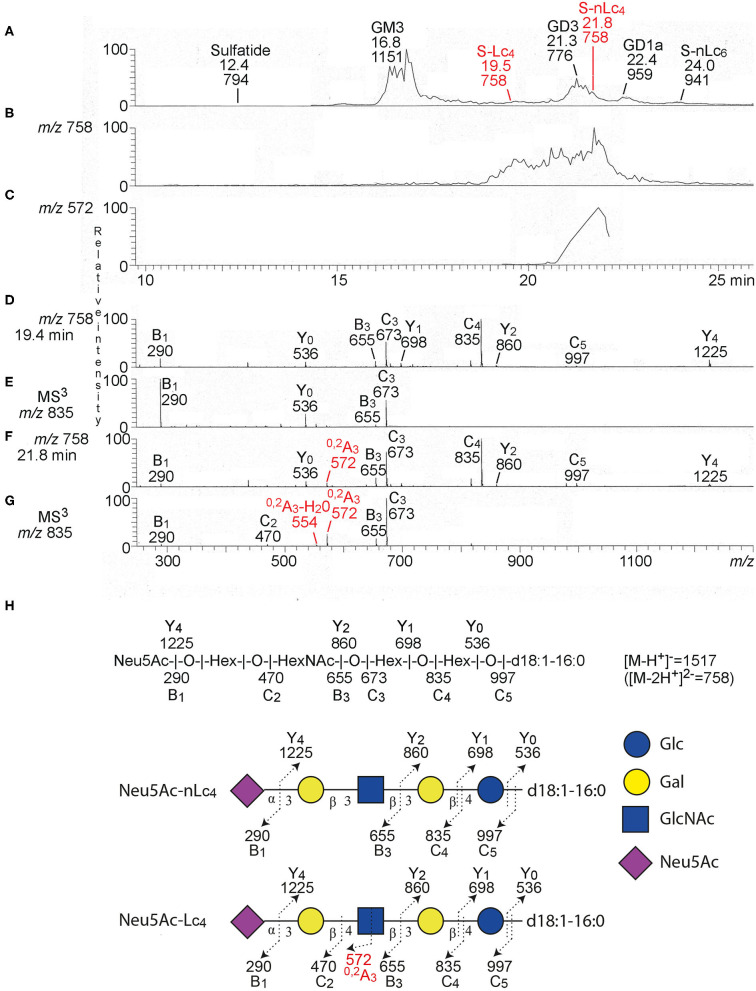
LC-ESI/MS of the total acid glycosphingolipids of ovarian cancer. (A) Base peak chromatogram from LC-ESI/MS of acid glycosphingolipids of ovarian cancer (Case 1). (B) Extracted ion chromatogram for m/z 757.5–758.5. (C) Extracted ion chromatogram for m/z 571.5–572.5. (D) MS2 of the ion at m/z 758 (retention time 19.4 min). (E) MS3 of the ion at m/z 835. (F) MS2 of the ion at m/z 758 (retention time 21.8 min). (G) MS3 of the ion at m/z 835. (H) Interpretation formulas. The proposed structures are depicted using the Symbol Nomenclature for Glycomics (SNFG) (30, 31), and nomenclature of fragments defined by Domon and Costello (32).The identification of glycosphingolipids was based on their retention times, determined molecular masses and subsequent MS2. Sulfatide, SO3-3Glcβ1Cer; GM3, Neu5Acα3Galβ4Glcβ1Cer; S-Lc4, Neu5Acα3Galβ3GlcNAcβ3Galβ4Glcβ1Cer; GD3, Neu5Acα8Neu5Acα3Galβ4Glcβ1Cer; S-nLc4, Neu5Acα3Galβ4GlcNAcβ3Galβ4Glcβ1Cer; GD1a, Neu5Acα3Galβ3GalNAcβ4(Neu5Acα3)Galβ4Glcβ1Cer; S-Lc6, Neu5Acα3Galβ4GlcNAcβ3Galβ4GlcNAcβ3Galβ4Glcβ1Cer.